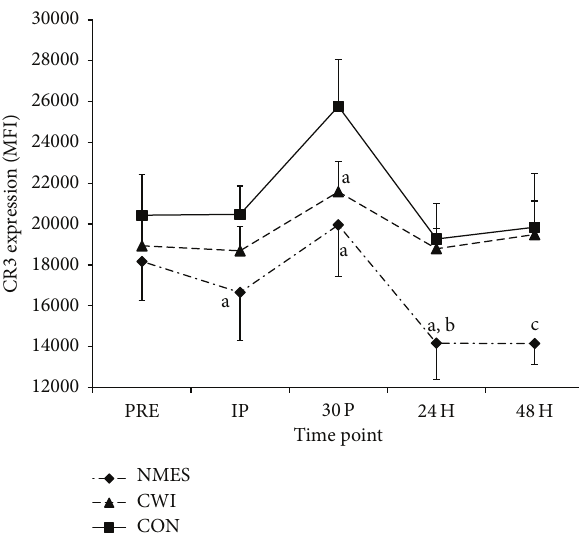
Figure 3: Expression of the complement receptor 3 (CR3) on CD14+ monocytes (mean ± SE). CR3 expression, as measured by mean fluorescence intensity before exercise (PRE), immediately after exercise (IP), and 30 minutes (30P), 24 hours (24 H), and 48 hours (48H) after exercise in neuromuscular electrical stimulation (NMES), cold water immersion (CWI), and control (CON) groups. (a) The value is “likely” lower than CON at the specified time point, (b) the value is “very likely” lower than CON at the specified time point, and (c) the value is “very likely” lower than CWI at the specified time